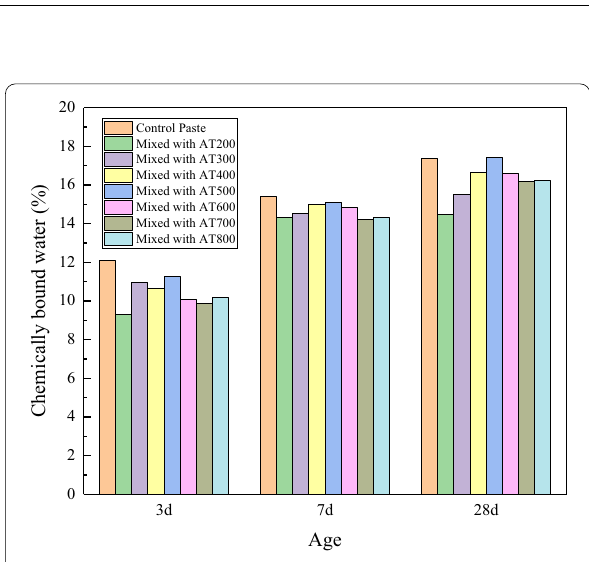
Fig. 6 Chemical bound water content of paste mixed with calcined attapulgite at different